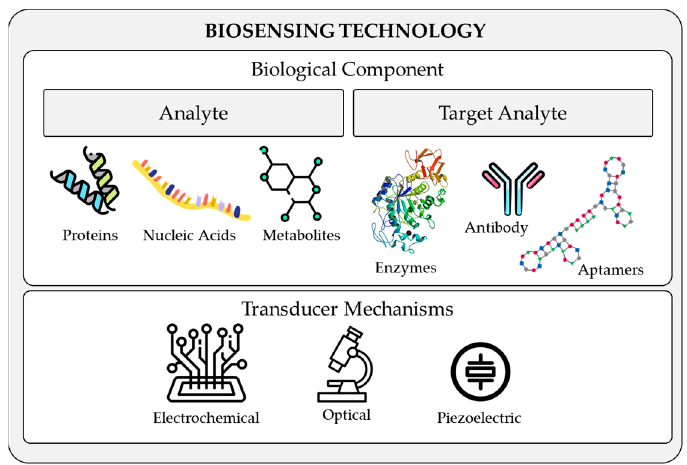
Figure 1. Schematic of different parts of a biosensor. Table 2. Summary of the transducer mechanisms used in biosensing and their advantages and disadvantages.